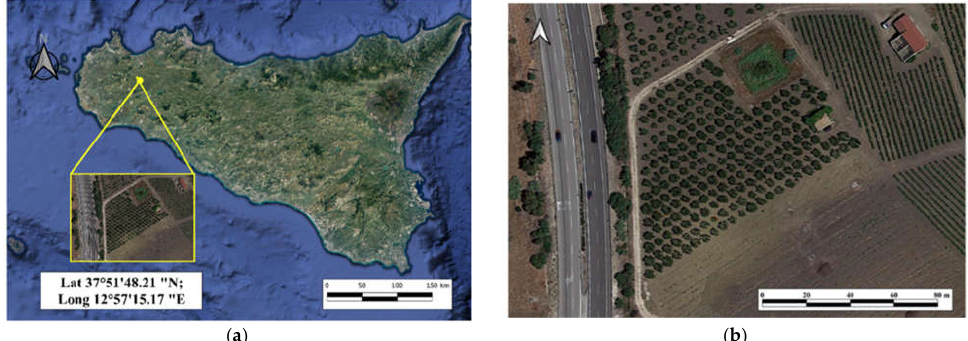
Figure 1. ( a ) Experimental site location on a scale of 1:1,200,000; ( b ) study area.